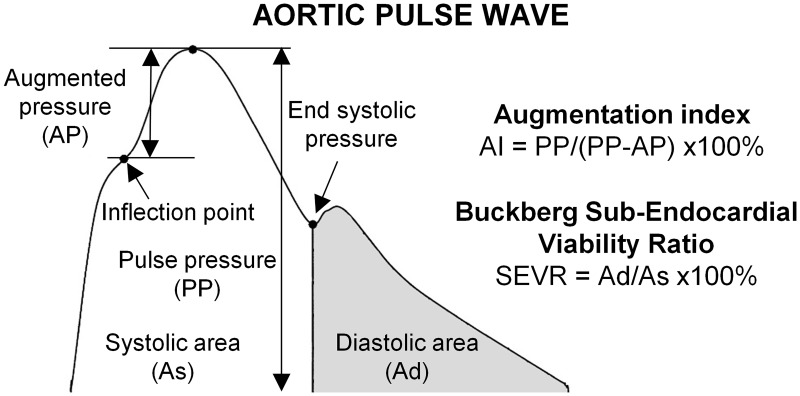
Features of the pulse wave in ascending aorta.Superposition of forward and reflected pressure waves results in certain amount of augmented pressure, with a characteristic inflection point located to the left of pressure peak in elderly subjects. In younger subjects inflection point is typically found to the right of pressure peak, what results in negative values of augmented pressure.